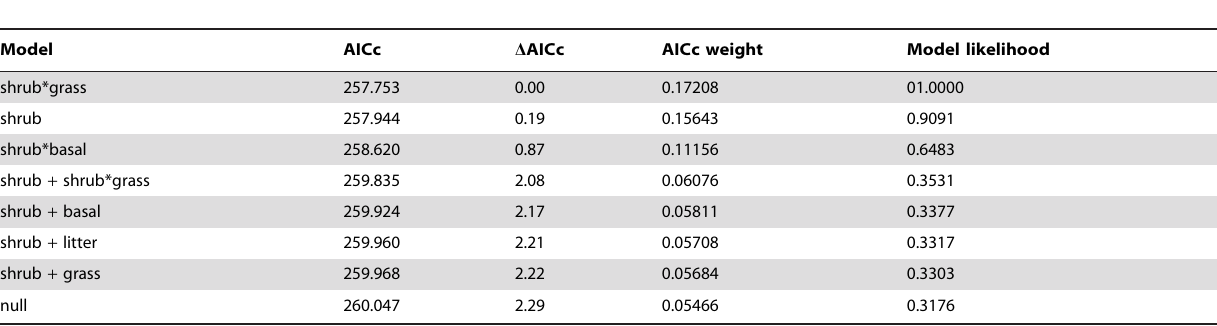
Table 4. Results from age-structured known fate survival models, constrained by vegetation characteristics.